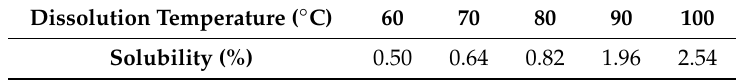
Table 2. E ff ect of temperature on dissolution yield of cellulose in oxalic acid /